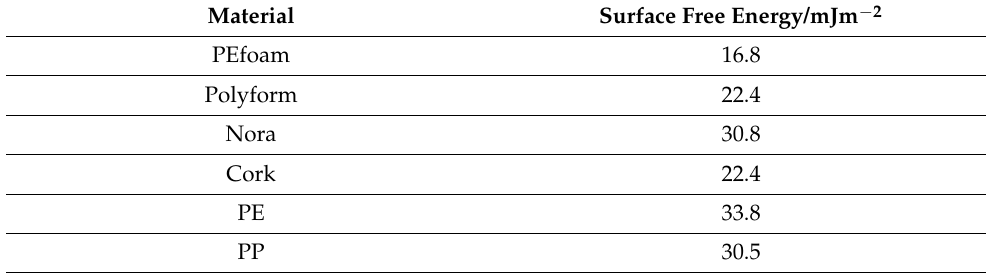
Table 2. Surface free